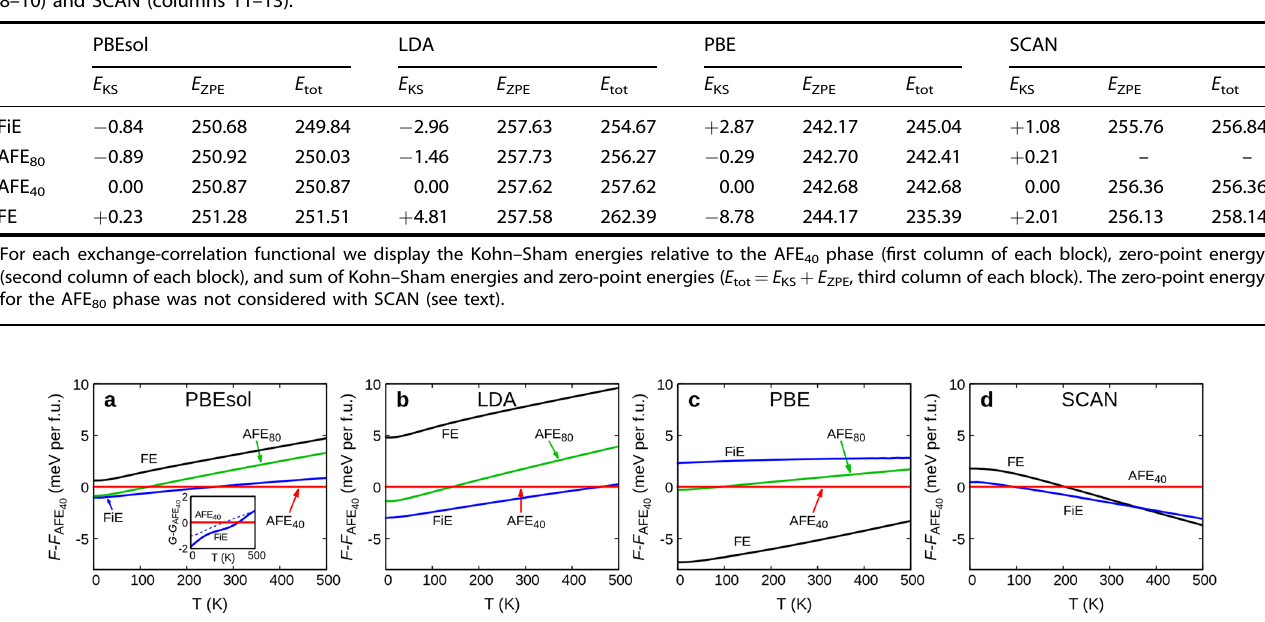
Table 2. Computed energies (in meV per formula unit) of the studied PbZrO 3 phases using PBEsol (columns 2 – 4), LDA (columns 5 – 7), PBE (columns 8 – 10) and SCAN (columns 11 – 13).